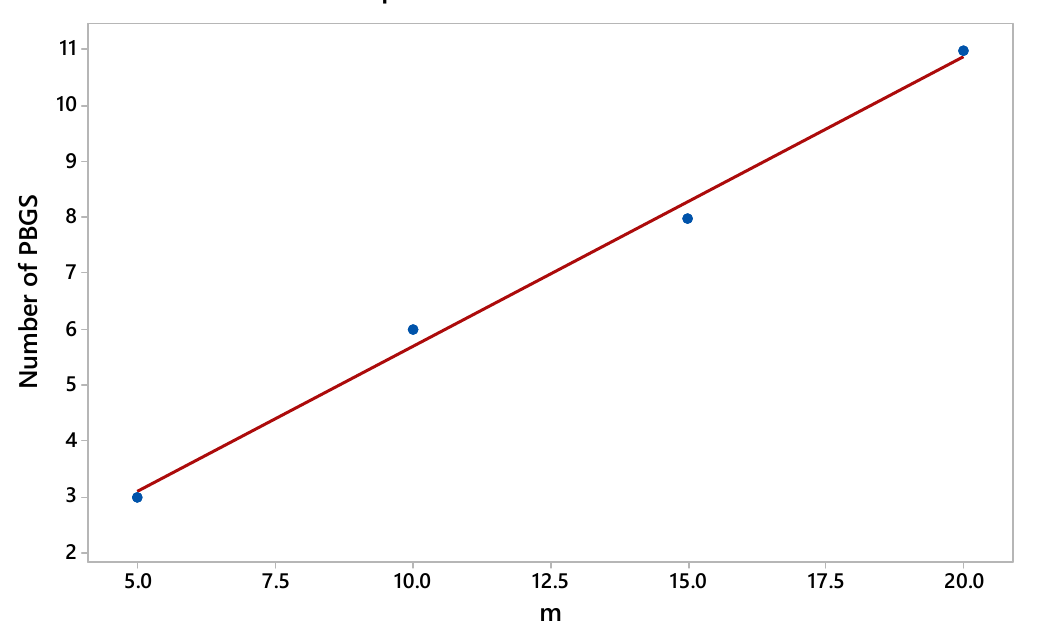
Figure 4. Number of PBGs as a function of the parameter m for 1D GF ( m , 1) sequence (3 rd iteration).